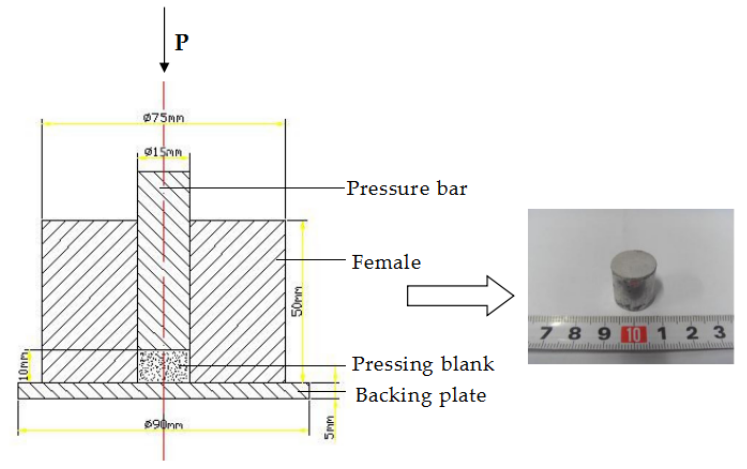
Figure 1. Powder compaction schematic diagram.